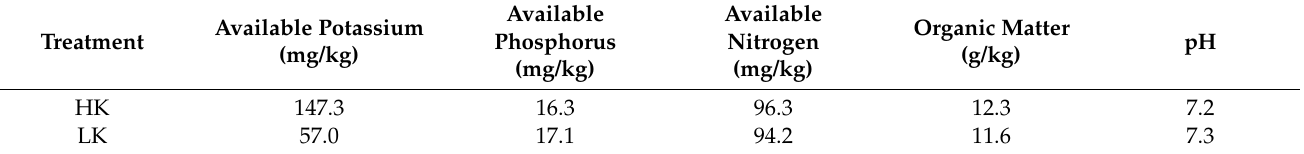
Table 2. Soil nutrient